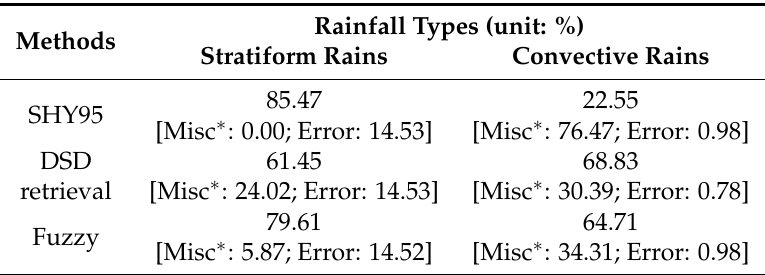
Table 5. Comparison of the percentages (%) of accuracy rate for stratiform and convective rain classification with the three different radar classification methods (SHY95, DSD retrieval, and fuzzy methods) at the Jincheon